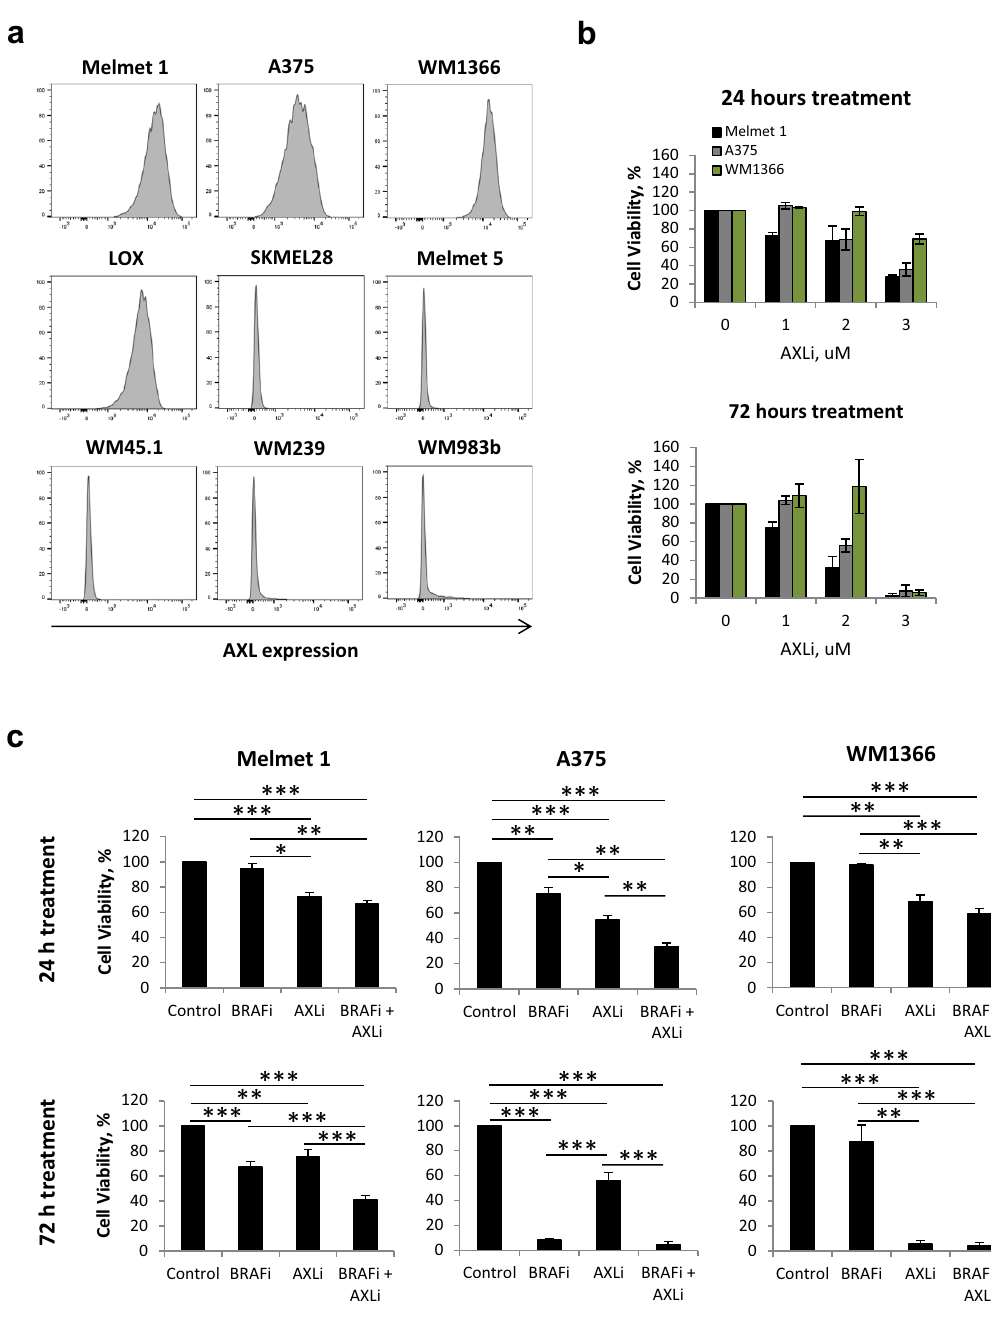
Figure 3. Melanoma cells show reduced cell viability following combined inhibition of AXL and BRAF. ( a ) The level of AXL (detected by flow cytometry) in nine melanoma cell lines. ( b , c ) Cell viability of three AXL high melanoma cell lines treated with different concentrations, as indicated, of AXLi ( b ) or 2 µM BRAFi, 1 µM AXLi (for Melmet 1), 2 µM AXLi (for A375), 3 µM AXLi (for WM1366) or a combination of both drugs ( c ) for 24 or 72 h. The treatment effect was scored by CTG assay and presented as % relative to the respective non-treated controls set to 100%. Average ± SEM, n = 3. * p ≤ 0.05; ** p ≤ 0.01; and *** p ≤